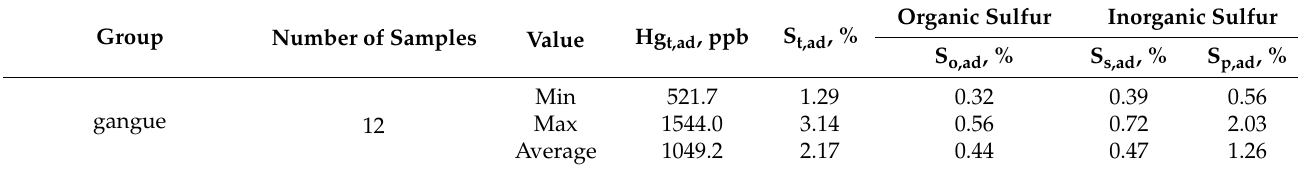
Table 5. Contents of Hg, sulfur, organic sulfur and inorganic sulfur in gangue samples.